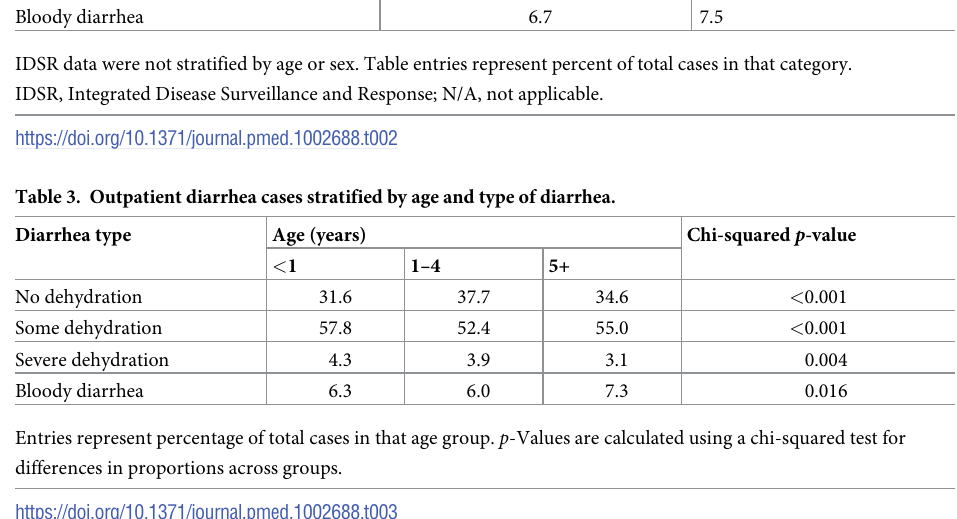
Diarrhea type No dehydration Some dehydration 55.1 Severe dehydration Bloody diarrhea 6.7 7.5 IDSR data were not stratified by age or sex. Table entries represent percent of total cases in that category. IDSR, Integrated Disease Surveillance and Response; N/A, not applicable.